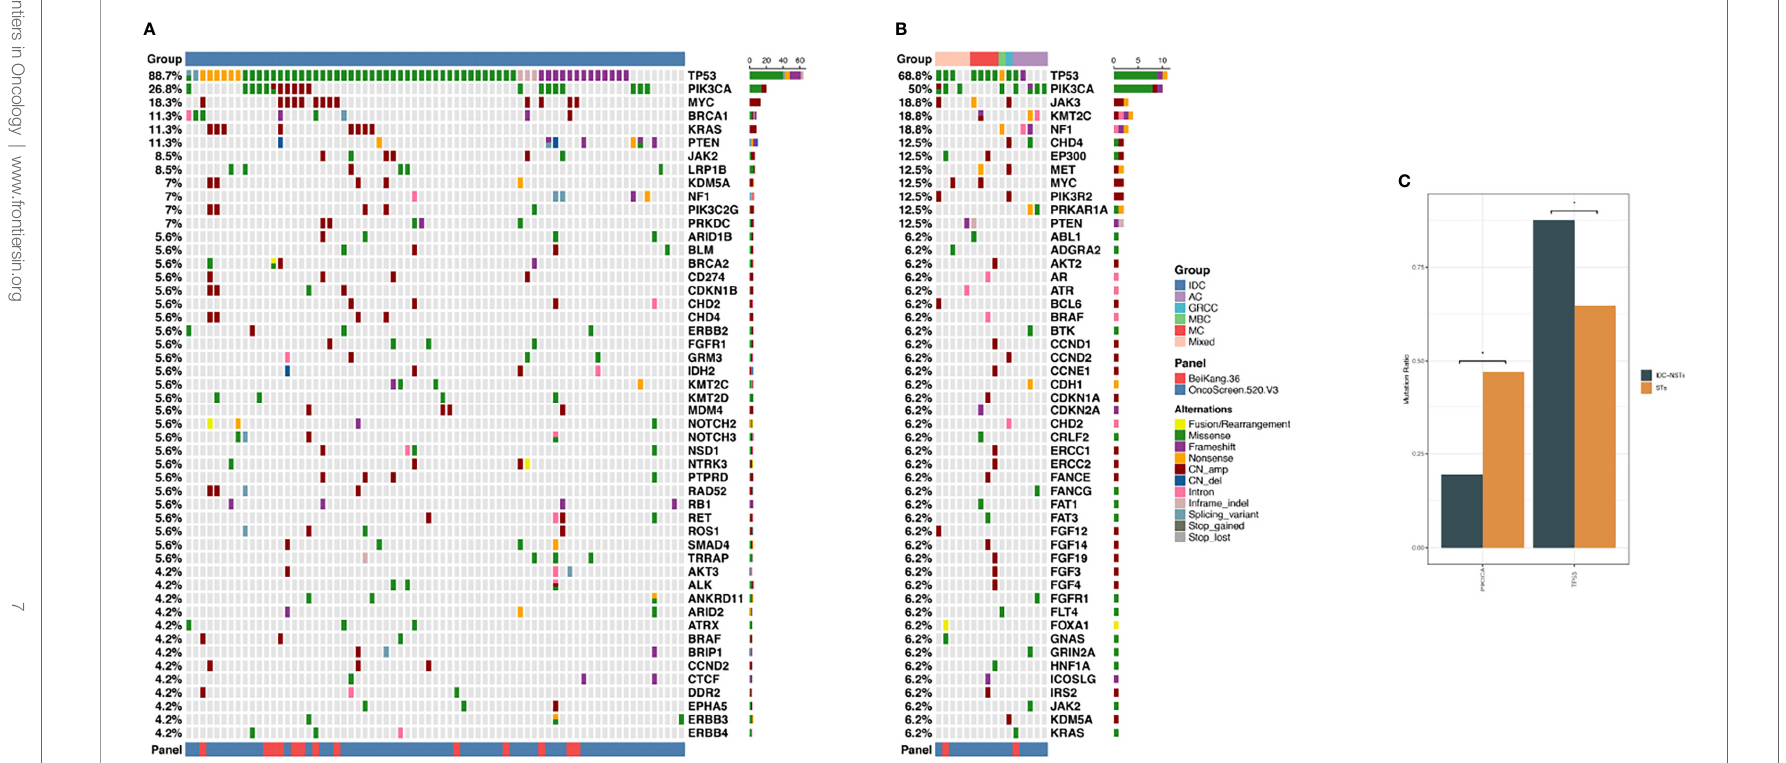
FIGURE 3 | (A) Summary of genomic features of the 72 NST cases of TNBC patients. (B) Summary of genomic features of the 17 ST cases of TNBC patients. (C) Differentially mutated genes between NSTs and STs TNBC patients. The X-axis represents the speci fi c genes. The Y-axis represents the percentage of samples with mutations in a speci fi c gene. * indicated p values <0.05. TNBC, triple-negative breast cancer; NST, no-special type; ST, special